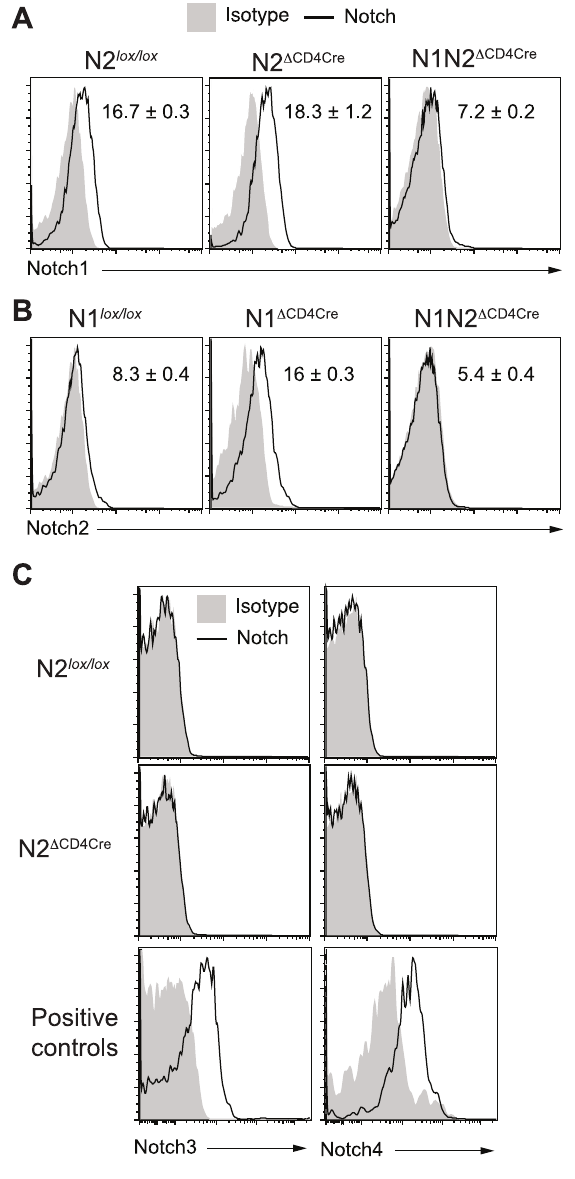
Figure 3. Increased N2 expression can compensate the absence of N1 on L.major stimulated CD4 + T cells. (A–C) Three weeks after L. major infection, dLN cells from the indicated mouse strains were isolated and restimulated for 16 h with UV-treated L. major . Notch1 (A), Notch2 (B), Notch3 and Notch4 (C) expression by CD4 + T cells was assessed by FACS. CD11c + CD8 a + splenic dendritic cells and CD4 2 CD8 2 CD25 + thymocytes were stained as positive controls for Notch3 and Notch4 respectively. Representative flow cytometry plots are shown. Numbers in plots represent mean fluorescence intensity MFI 6 SEM of $ 3 mice per group. Data are representative of 3